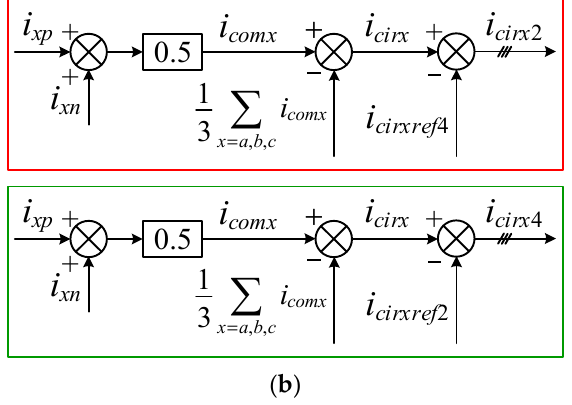
Figure 7. Block diagram of the proposed MCCIC-based peak arm current minimization technique of the MMC: ( a ) overall control block diagram; ( b ) block diagram for calculating decoupling actual values of the SOCC and the FOCC.